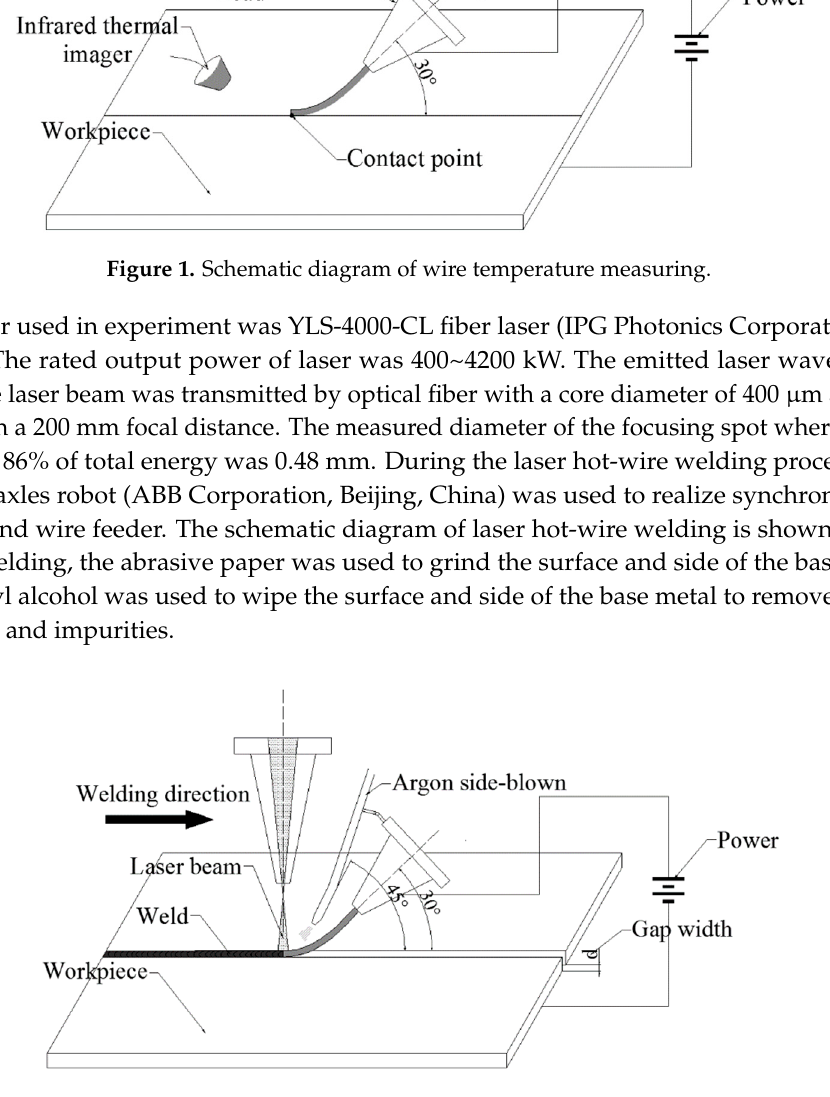
Figure 2. Schematic diagram of laser hot-wire welding.